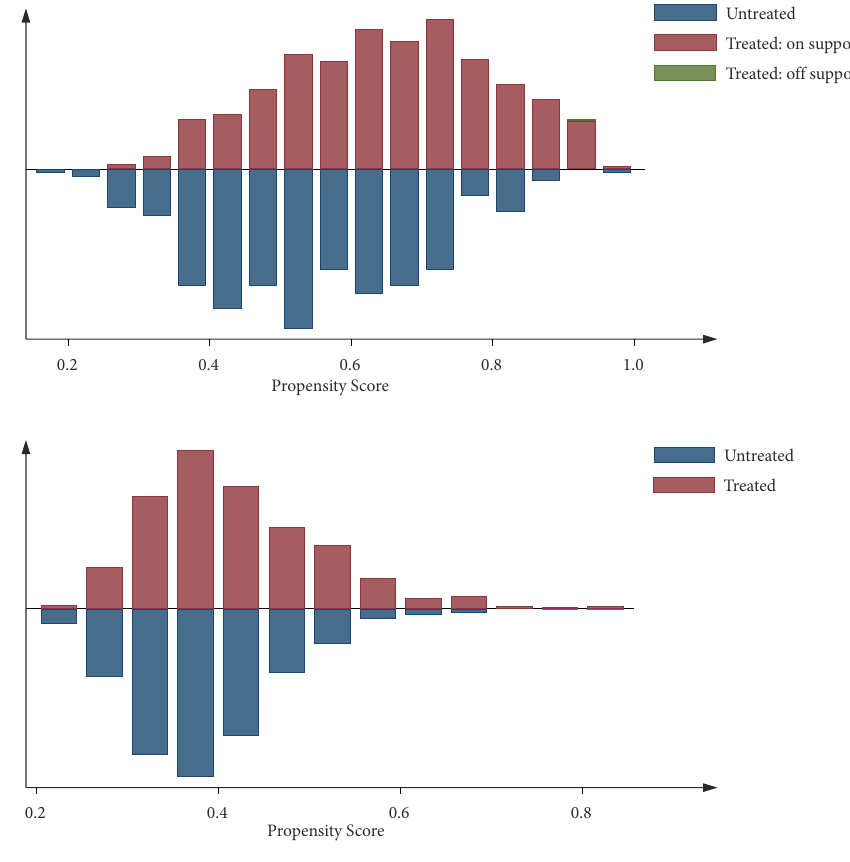
Figure 2. Distribution of propensity score Table 7. Estimation results of the PSM